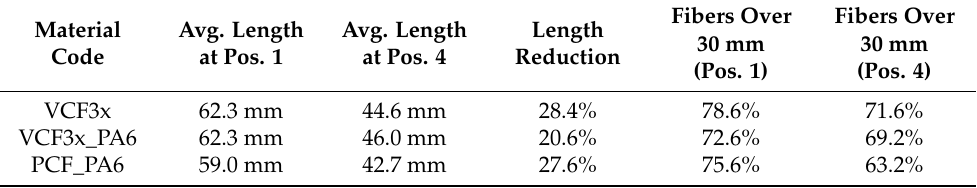
Table 5. Fiber length of VCF, VCF_PA6, and PCF_PA6 at pos. 1 and pos. 4.